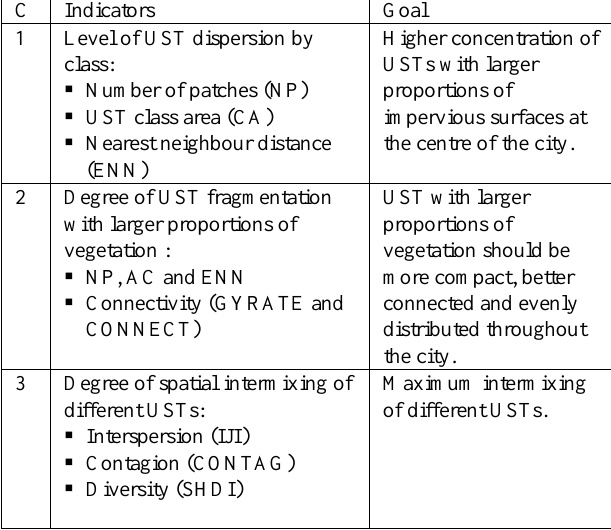
Table 1: Proposed indicators for urban sustainable planning using the three selected criteria (C). Acronyms in capital letters in brackets indicate the name of the metric as used in FRAGSTATS (McGarigal et al., 2012).